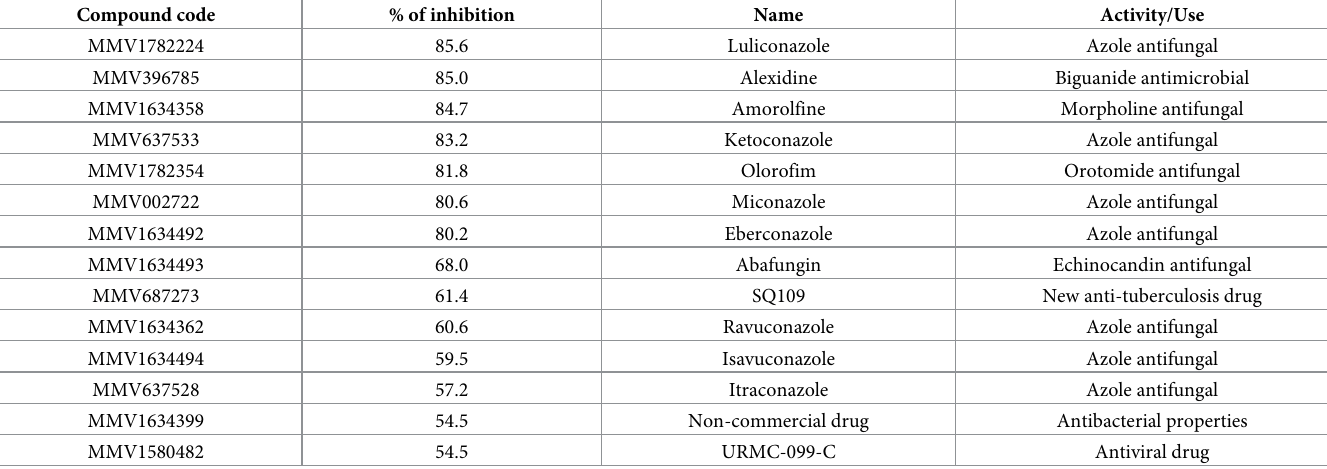
Table 1. Identification of the selected compounds from the screening of the Pandemic Response Box 1 library. Compound